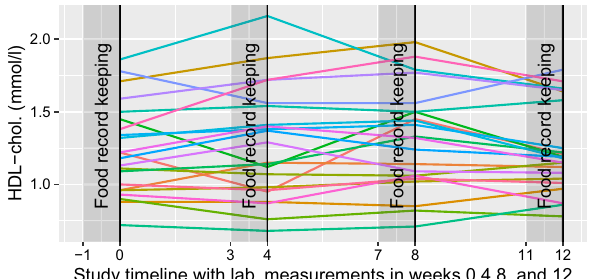
Figure 1. The progress of HDL cholesterol concentration for 10 out of all 106 subjects during the 12-week study in the Sysdimet data. The concentrations are measured at weeks 0, 4, 8, and 12 and the food records are kept in a week before the measurement. The figure is plotted with ggplot2 package for R language (v 3.3.2, https:// ggplo t2. tidyv erse.